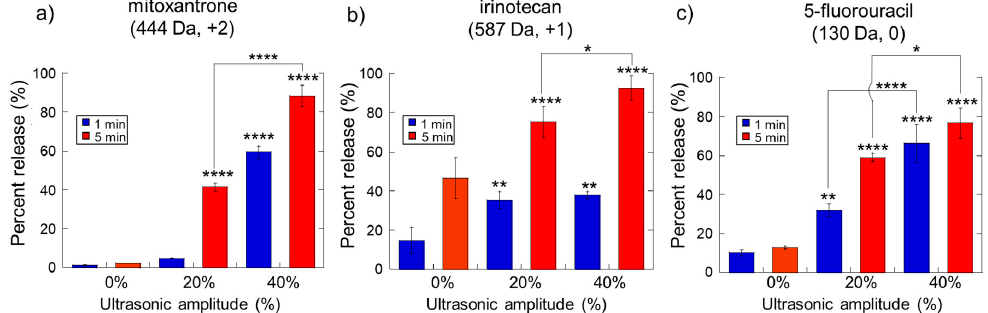
Figure 2. The amplitude and duration of ultrasonic stimulation impact the amount of chemotherapeutic released. Release vs. ultrasonic amplitude for mitoxantrone ( a ), irinotecan ( b ), and 5-fluorouracil ( c ). *, **, ***, and **** indicate statistically significant differences with p < 0.05, 0.01, 0.001, and 0.0001, respectively, compared to controls (0% amplitude) unless otherwise specified with lines. N = 4.